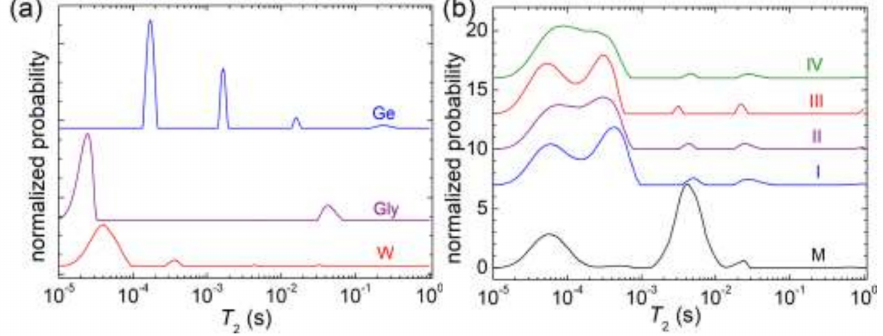
Figure 10. The 1 H NMR T 2 -distributions measured for ( a ) raw materials: Whey (red), Glycerin (plume), Ge (blue), and ( b ) Whey: Gel with different content of